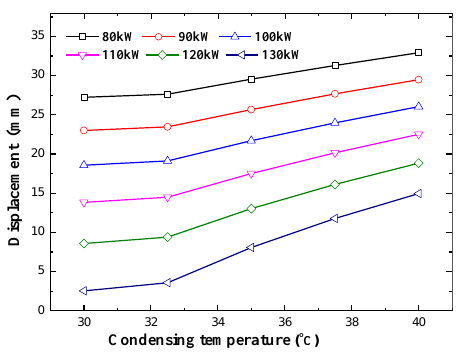
Figure 22. Displacement of the volume ratio slide valve vs. condensing temperature.